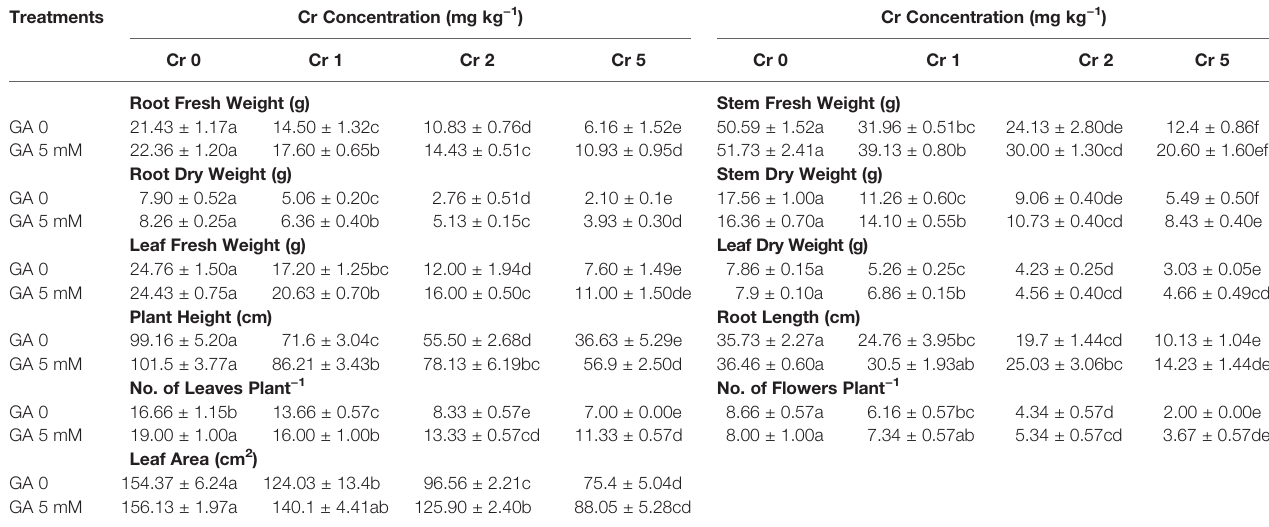
TABLE 1 | Effect of different concentrations of Cr alone and/or in combination with GA on agronomic traits of sun fl ower.